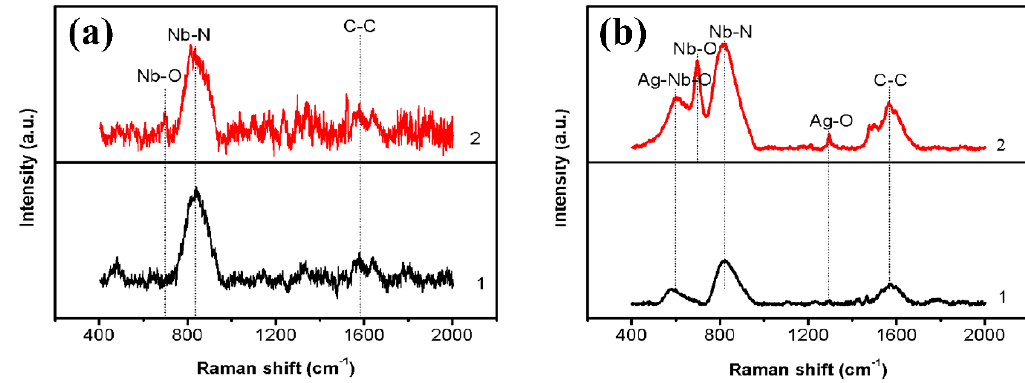
Figure 13. Raman spectra of worn tracks of NbCN-12.9 at.% Ag film at ( a ) 300 °C and ( b ) 500 °C. SEM image of the wear track, 3D, 2D images, and EDS analysis of the NbCN-12.9 at.% Ag film